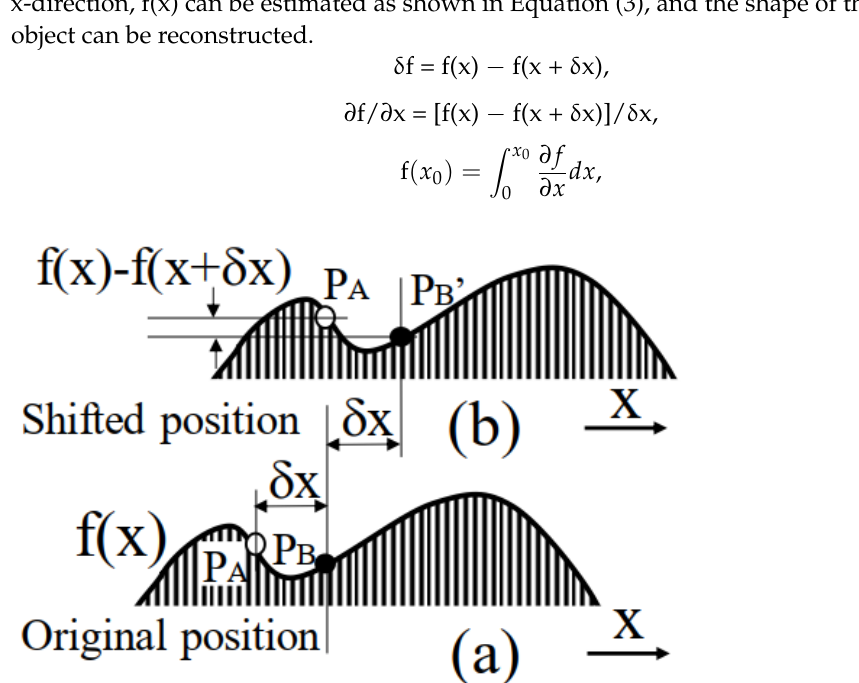
Figure 1. Principal of analyzing method: ( a ) Section of measured object at original position; ( b ) Section of measured object at shifted position.